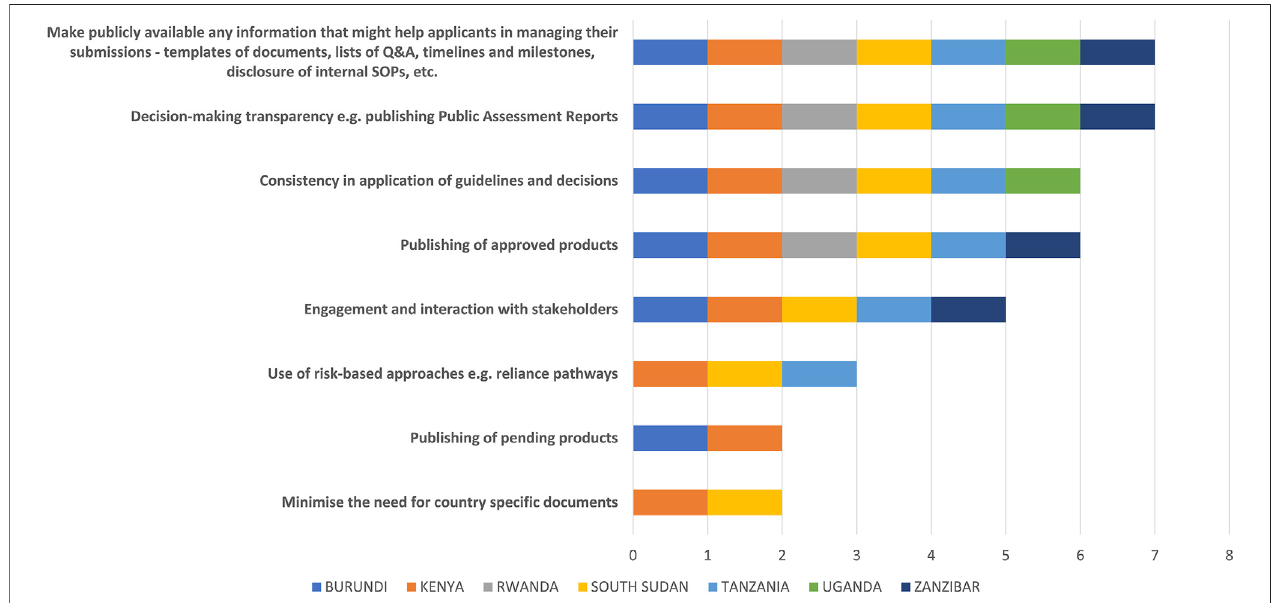
FIGURE 6 | Ways to improve effectiveness of the EAC-MRH